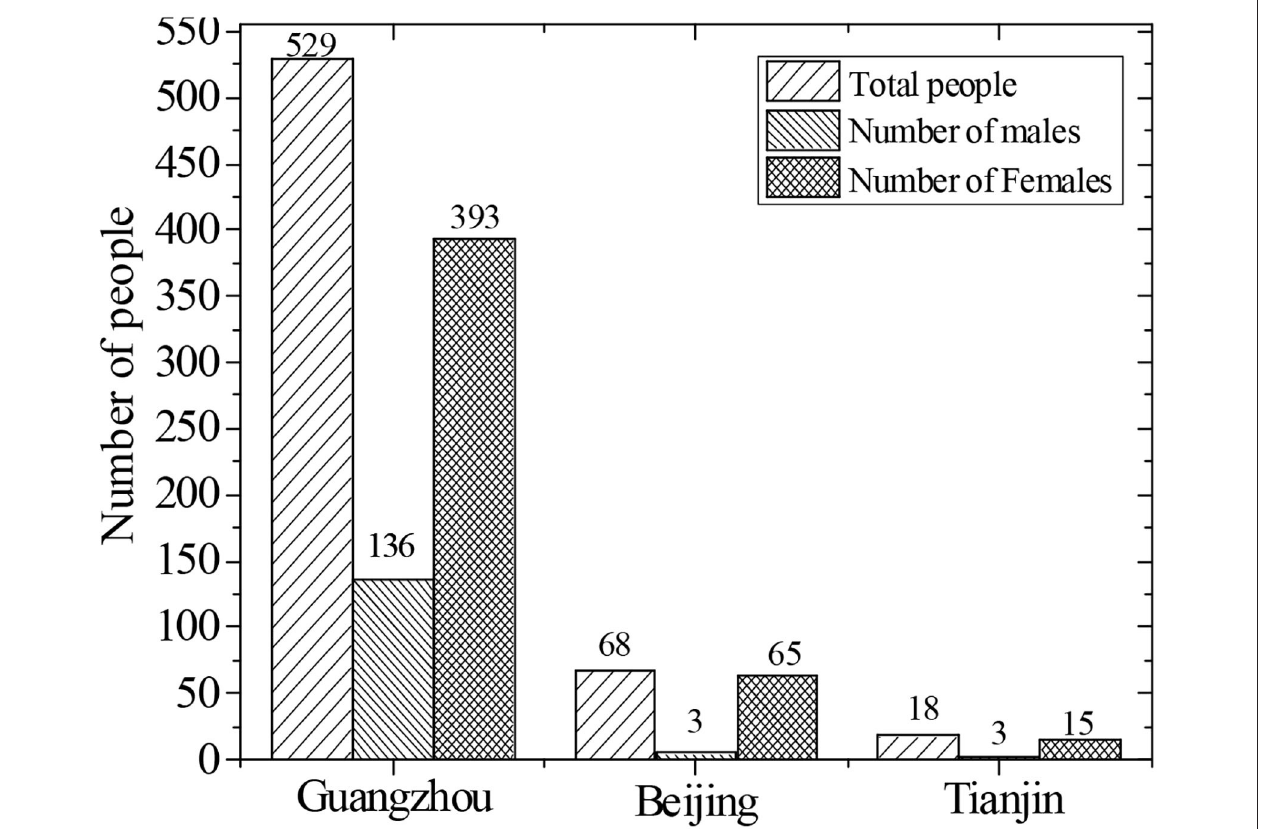
FIGURE 1 | Figure of survey number and gender distribution of the subjects by region.